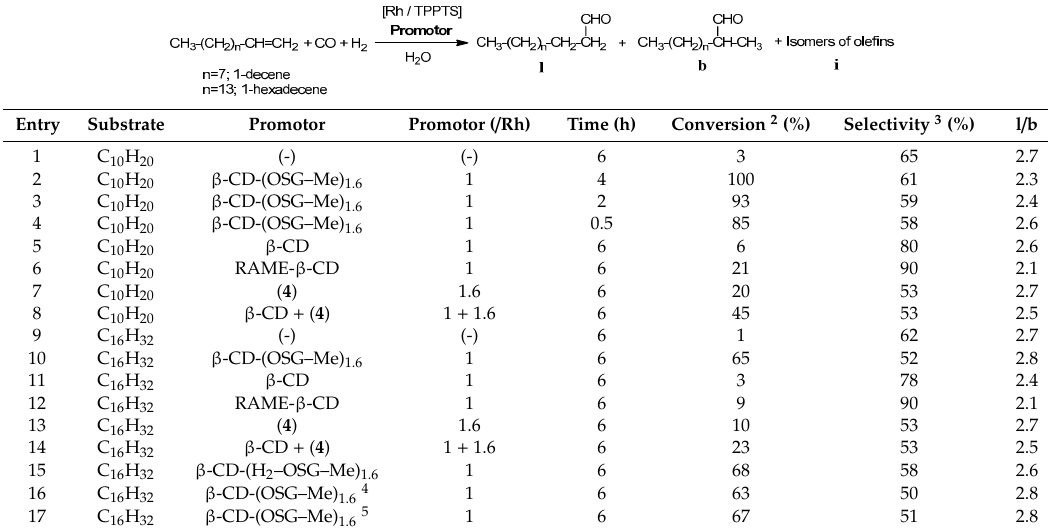
Table 2. Rhodium-catalyzed hydroformylation of 1-decene and 1-hexadecene in presence of various promotors. 1